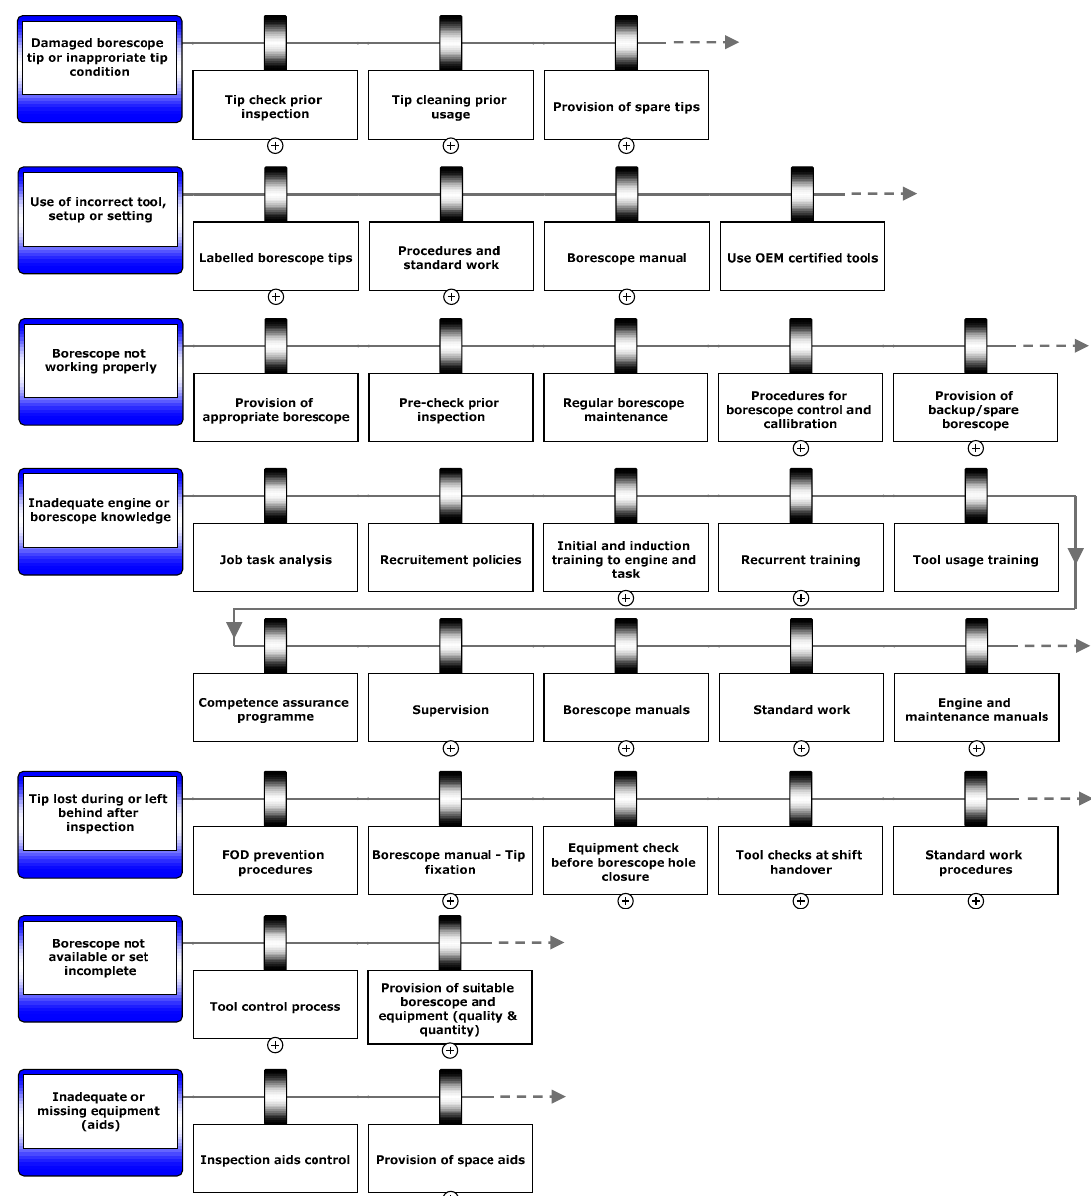
Figure 6. Left half of the Bowtie diagram with threats and prevention barriers.